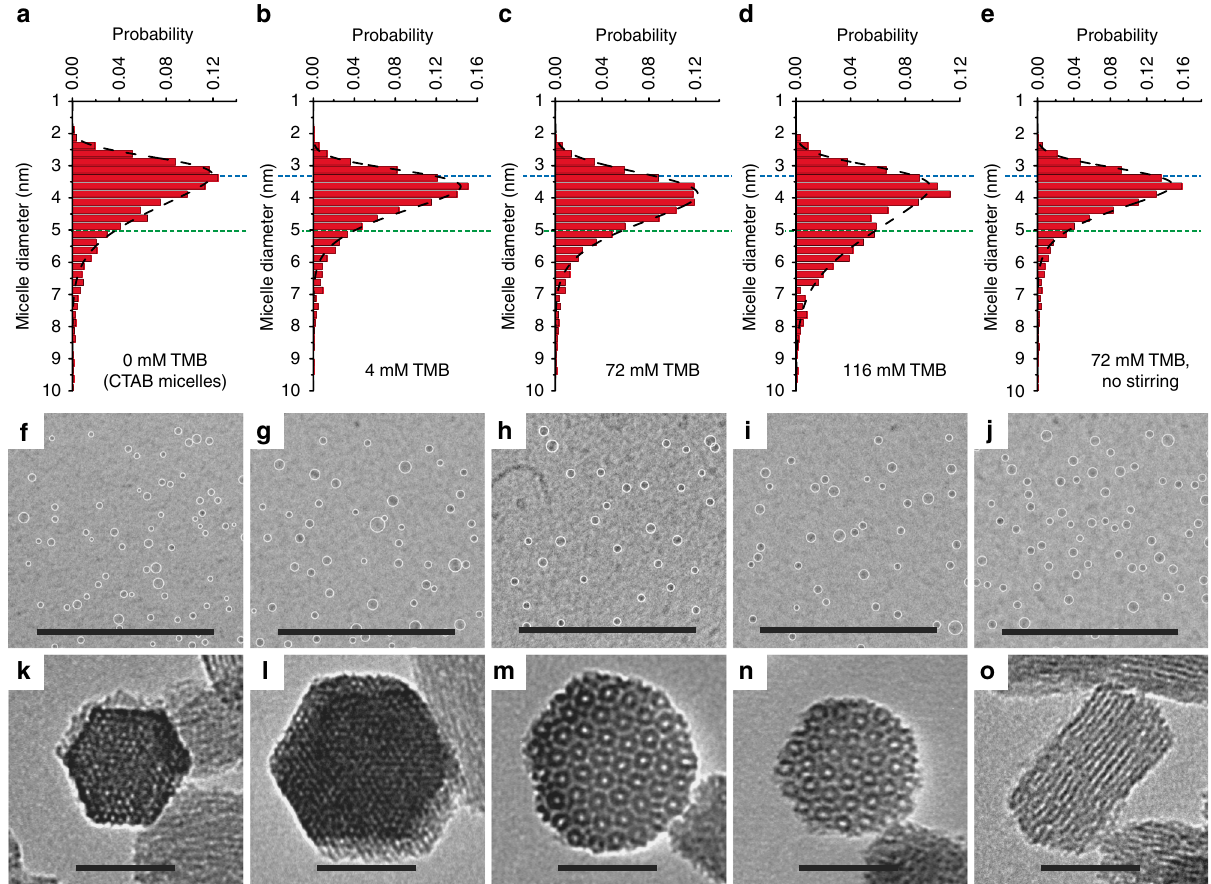
Fig. 3 Cryo-TEM of native micelle solutions prepared using varying mesitylene concentrations and stirring rates. a – e Micelle size distributions before silane addition, prepared using 0mM ( a ), 4mM ( b ), 72mM ( c ), and 116mM ( d ) mesitylene (TMB) under constant stirring (600rpm) and 72mM ( e ) TMB with no stirring. The ammonium hydroxide concentration was kept constant (150mM) across all solutions. Distribution fi ts are shown using black dashed lines . Blue dashed lines indicate the peak position of the micelle size distribution of CTAB micelles without TMB and green dashed lines are shown as an additional reference for comparison across different plots. Comparison between the micelle size distributions demonstrates that although the peak position does not vary substantially, the combination of increased TMB concentration and mechanical agitation causes a shift to larger average micelle diameters and an increase in the frequency of large micelles with sizes above 5nm. f – j Cryo-TEM images of the micelle solutions before silane addition corresponding to conditions used in a – e , respectively. Individual micelles are identi fi ed using a self-written python code and are circled in white . k – o TEM images of MSNs synthesized via adding TMOS and APTMS into micelle solutions corresponding to conditions used in a – e , respectively. Scale bars in both sets of images are